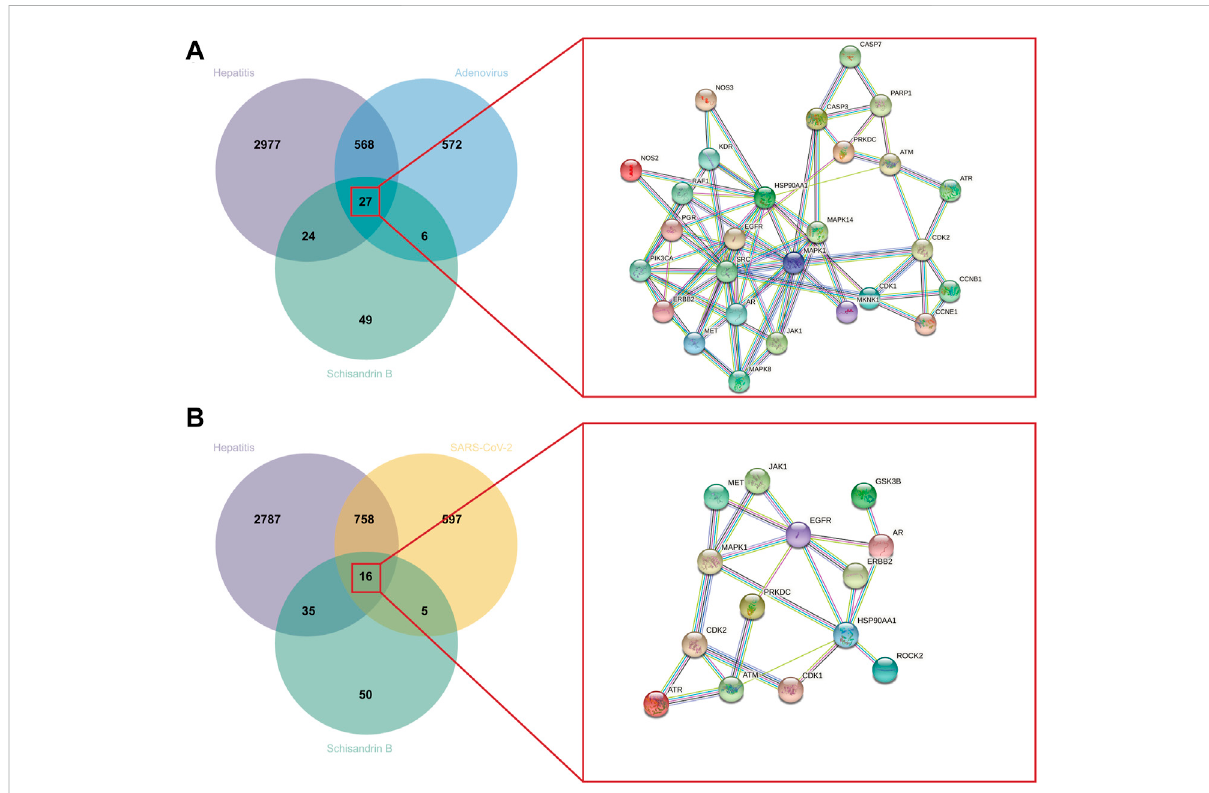
FIGURE 4 Identi fi cation of SchB targets on adenovirus/SARS-CoV-2_hepatitis. (A) Venn diagram representing the 27 intersecting targets of SchB with adenovirus_hepatitis (left). A PPI network was constructed with these common genes, which met the conditions interaction score of > 0.9, and disconnectednodeswerehidden(right). (B) Venndiagramrepresentingthe16intersectingtargetsofSchisandrinBwithSARS-CoV-2_hepatitis(left), and the PPI network met the above fi lter criteria